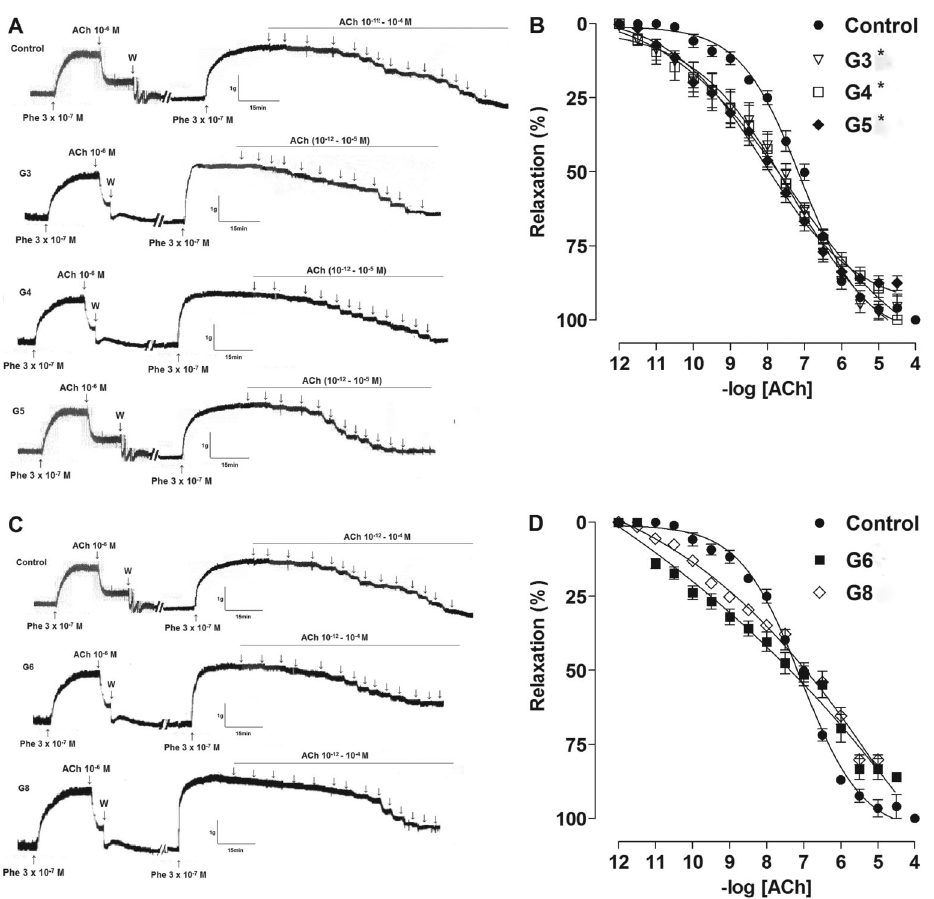
Figure 2. Representative traces and relaxant effect on rat aorta induced by acetylcholine in control, G3 G4, and G5 ( A and B , lower intensities), and G6 and G8 ( C and D , higher intensities) groups. Data are reported as means ± SE (n=5 per group). G3, G4, G5, G6 and G8: exercise intensity based on loading with 3, 4, 5, 6 and 8% of body weight, respectively, during swimming exercise. *P o 0.05 vs control (one-way ANOVA). Phe: phenylephrine; W: wash.